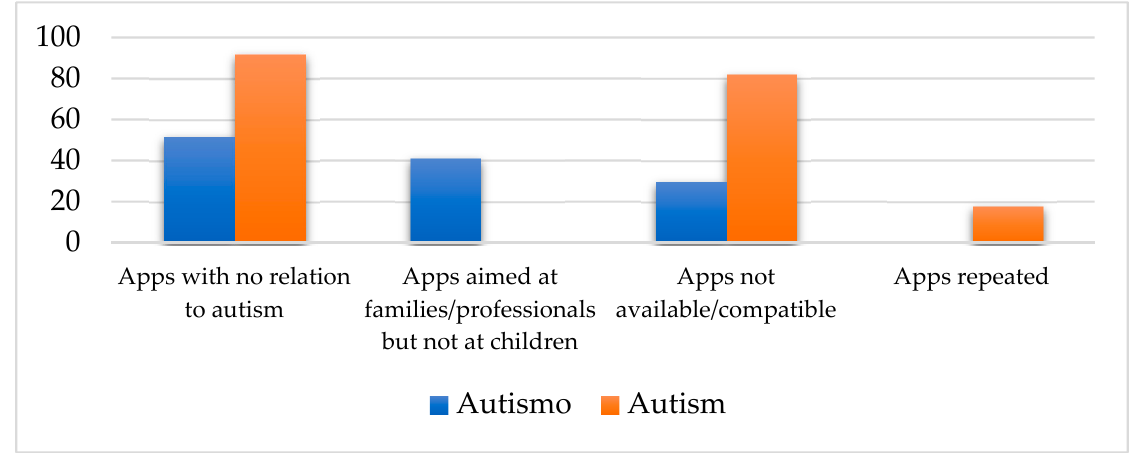
Figure 1. App exclusion criteria.